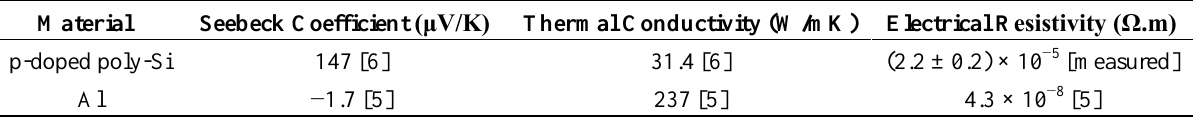
Table 1. Thermal and electrical properties of the materials used for the design of the